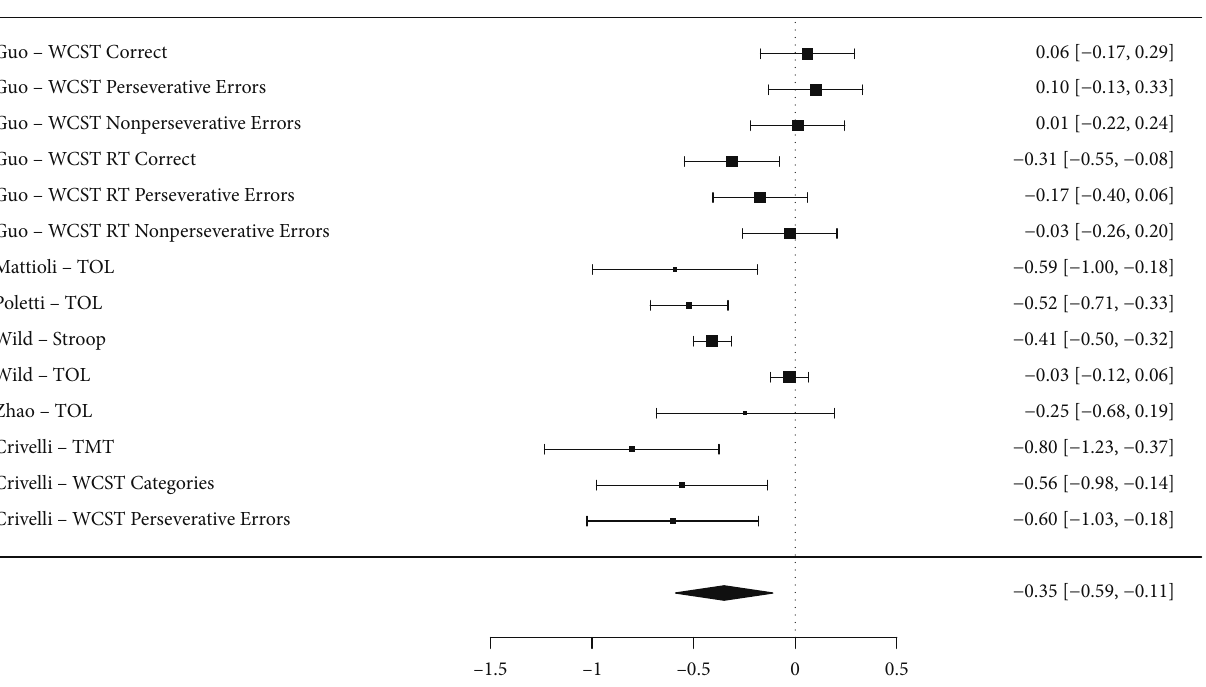
Figure 2: Forest plot for the multilevel random e ff ects model. WCST — Wisconsin Card Sorting Test; RT — reaction times; TOL — Tower of London; Stroop — Stroop Color and Word Test; TMT – Trail Making Task -B. Squares represent original e ff ect sizes; their area corresponds to the weight of the study (number of participants). Black diamond at the bottom is the pooled e ff ect